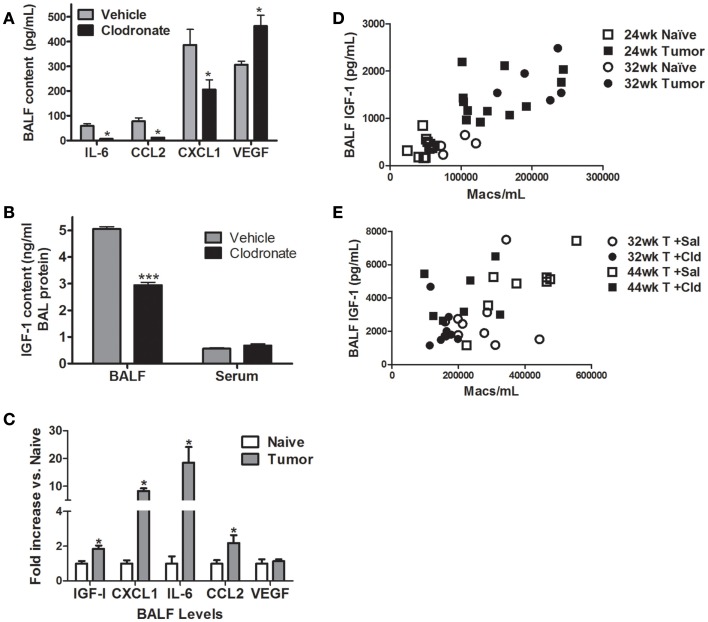
Effects of macrophage depletion on BAL cytokine content. Cytokine levels were determined in BALF from naïve (white bars), vehicle liposome (gray bars), or clodronate liposome (black bars) treated mice 44 weeks after urethane treatment. (A) Clodronate administration decreased IL-6, CCL2, and CXCL1 in BALF, while VEGF increased 1.5-fold. Data presented as mean ± SEM, n = 4–6 mice/group (*p < 0.05 vs. vehicle treated mice). (B) BALF IGF-I levels decreased with clodronate treatment in AC-bearing mice (***p < 0.001 vs. vehicle). (C) Fold change in BALF IGF-I, IL-6, CXCL1, CCL2, and VEGF levels in age-matched naïve and tumor-bearing mice 32 weeks after urethane exposure (*p < 0.05) (D) Correlation between IGF-I and BAL macrophage number in naïve and urethane-treated mice 24 and 32 weeks after urethane treatment (Spearman ρ = 0.8055, p < 0.0001). (E) Correlation between IGF-I and BAL macrophage number in 44-week urethane mice treated with saline and clodronate liposomes (Spearman ρ = 0.4990, p < 0.0031).